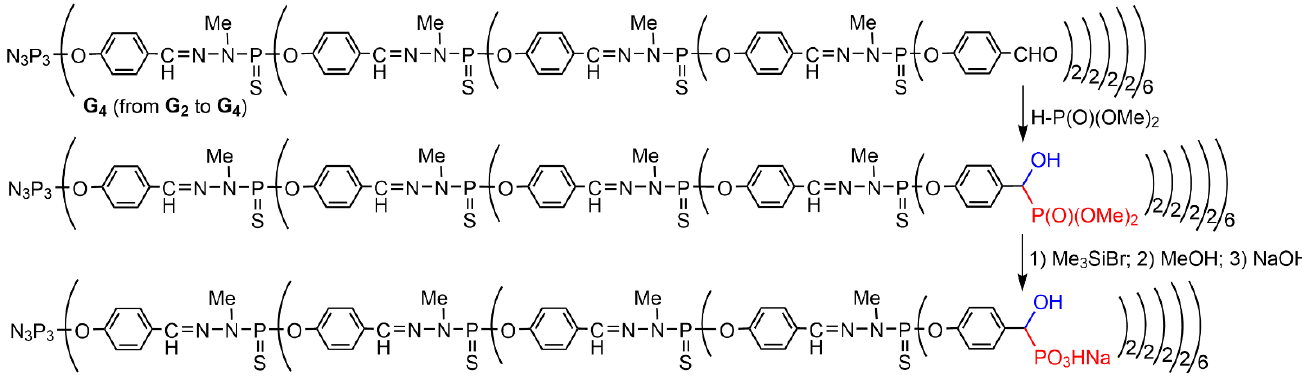
Figure 8. Dendrimers linked to SiO 2 NPs and hosting Ag/Ag 2 O NPs exhibiting antibacterial activity.